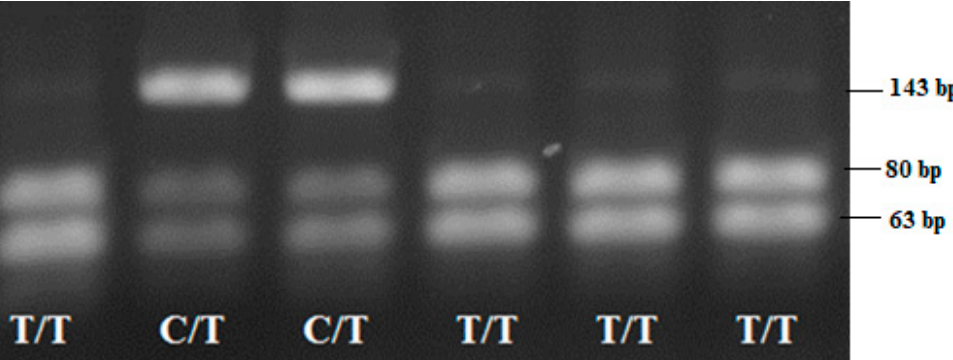
Figure 7. RFLP-PCR electropherogram representing the genotypes according to the IL17F 7488 T/C SNP: T/T-genotype was visualized with two DNA bands (80 bp and 63 bp); C/T-genotype exhibited three bands (143 bp, 80 bp and 63 bp) and the C/C-genotyped (143 bp) was not observed among the studied group.